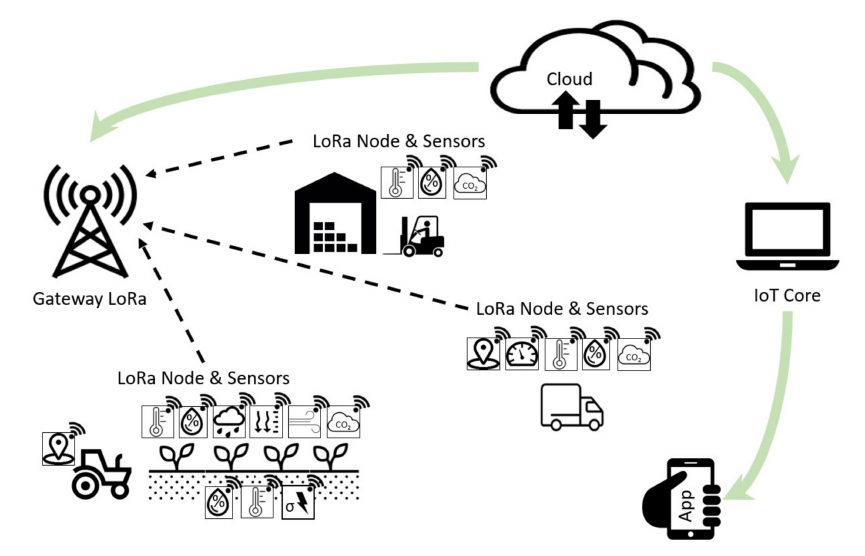
Figure 4. Schematic of IoT implementation using LoRa